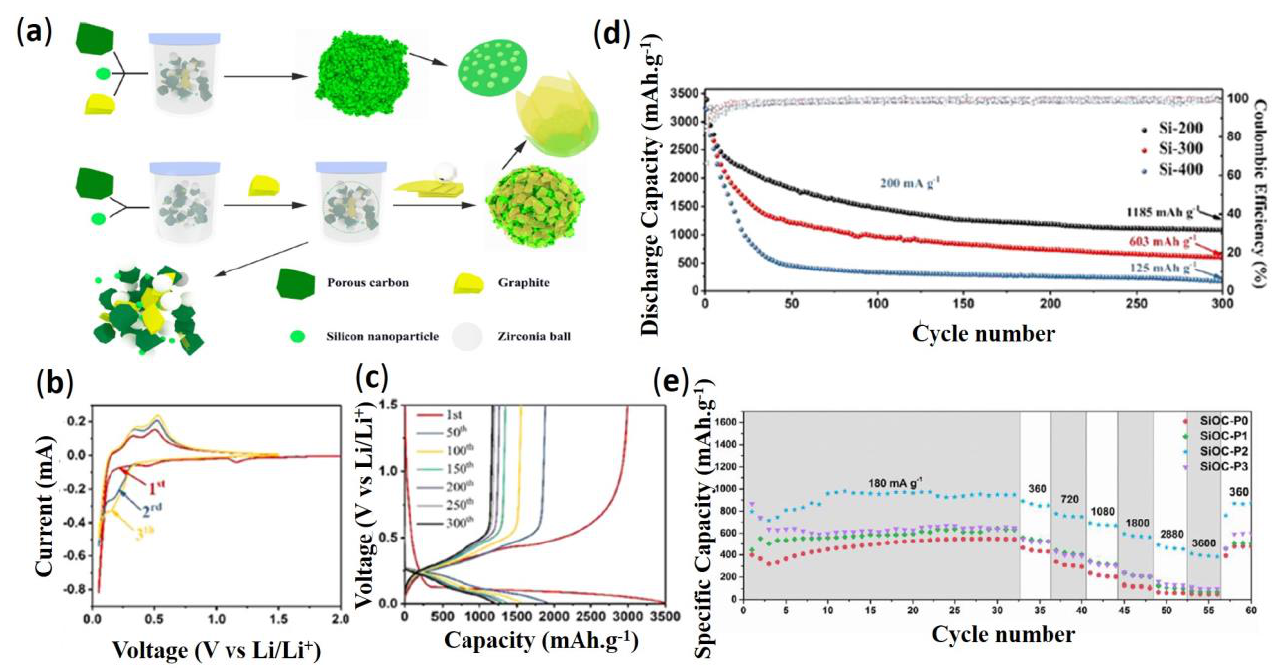
Figure 4. ( a ) Schematic illustration of the preparation process of amorphous carbon-coated silicon [74], ( b ) CV curves of Si-200 at a scan rate of 0.1 mV · s − 1 ; ( c ) Galvanostatic discharge/charge profiles of Si-200 at 0.2 A · g − 1 ; ( d ) Cycling performance of various nano-Si at 0.2 A · g − 1 [81]; and ( e ) Rate capability of the different silicon oxycarbide (SiOC) samples measured at various C-rates from 180 to 3600 mA · g − 1 [82].